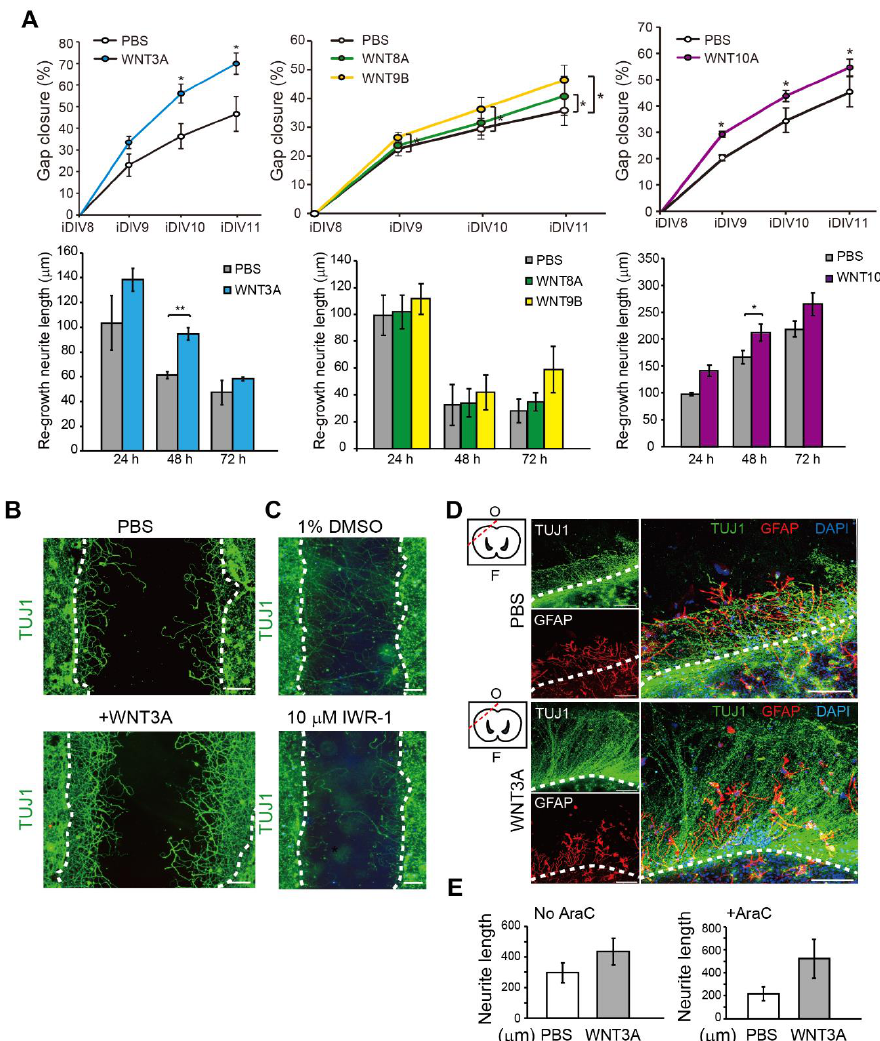
Figure 3. Recombinant WNT3A promotes regeneration of injured cortical neurons and brain tissues. ( A ) Cortical neurons were pre-treated with PBS, WNT3A, WNT8A, WNT9B, or WNT10A recombinant proteins prior to injury on DIV8. Upper: The percentages of gap closure were calculated from iDIV8 to iDIV11. Bottom: The lengths of re-growing neurites were measured between 0–24 h, 24–48 h, and 48–72 h after injury. Data are presented as mean ± SEM ( n = 4 for WNT3A and WNT9B experiments; n = 5 for WNT10A experiment). * p ≤ 0.05, ** p ≤ 0.01 (paired Student’s t -test). ( B ) Cortical neurons with or without WNT3A (50 ng / mL) pre-treatment were fixed and subjected to immunofluorescence staining with anti-TUJ1 antibody (neurites) on iDIV11. ( C ) Cortical neurons were treated with 1% DMSO or IWR-1 prior to injury on DIV8. Neurons were subjected to immunofluorescence staining with anti-TUJ1 antibody on DIV11 and the representative images are shown. Dashed lines in ( B , C ) indicate the borders of the injured gap. Scale bar, 100 µ m. ( D ) The e ff ect of WNT3A on neuronal regeneration was assessed using organotypic brain slice culture. Brain slices were injured at the olfactory tubercle on DIV0, as indicated by the red dashed line in the upper left atlas map, and cultured with or without WNT3A (50 ng / mL) in AraC-containing medium. Brain tissues were fixed on iDIV4 and subjected to immunofluorescence staining with anti-TUJ1 (green) and anti-GFAP (red, glia) antibodies, and DAPI (blue). The border of injured sites is depicted by white dashed lines, and remaining brain tissue is underneath the lines in each panel. F: Frontal lobe; O: Occipital lobe. Scale bar, 100 µ m. ( E ) The length of regenerating neurites from the brain slices treated with PBS, WNT3A, AraC + PBS, or AraC + WNT3A were calculated. Data are presented as mean ± SEM ( n = 4). Data were analyzed using non-parametric Mann–Whitney